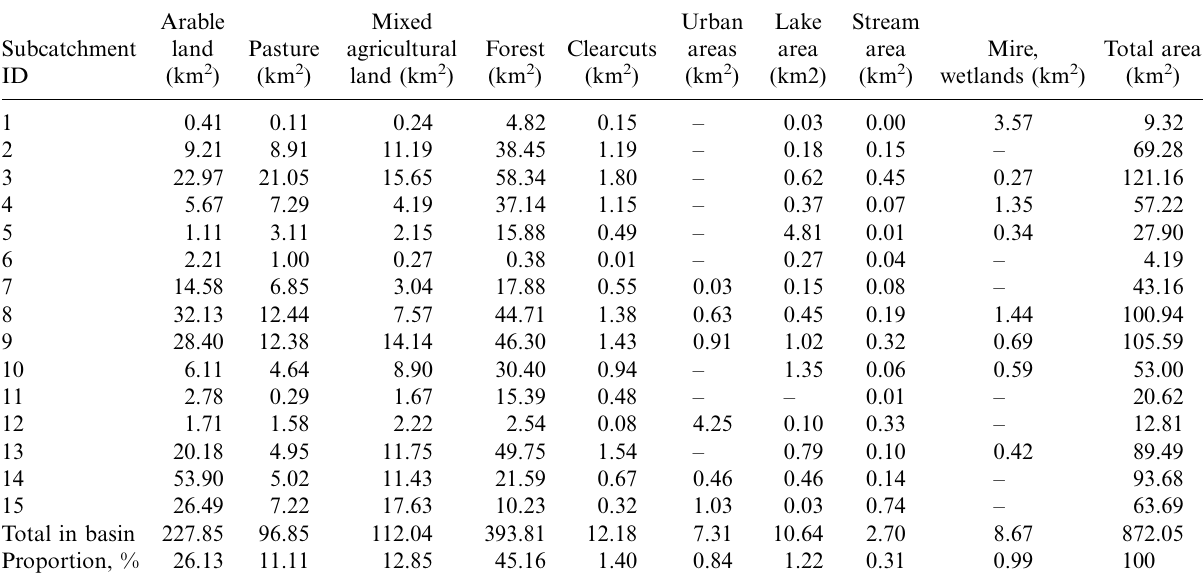
Table 2. Land use in Be¯rze River subcatchments (CLC